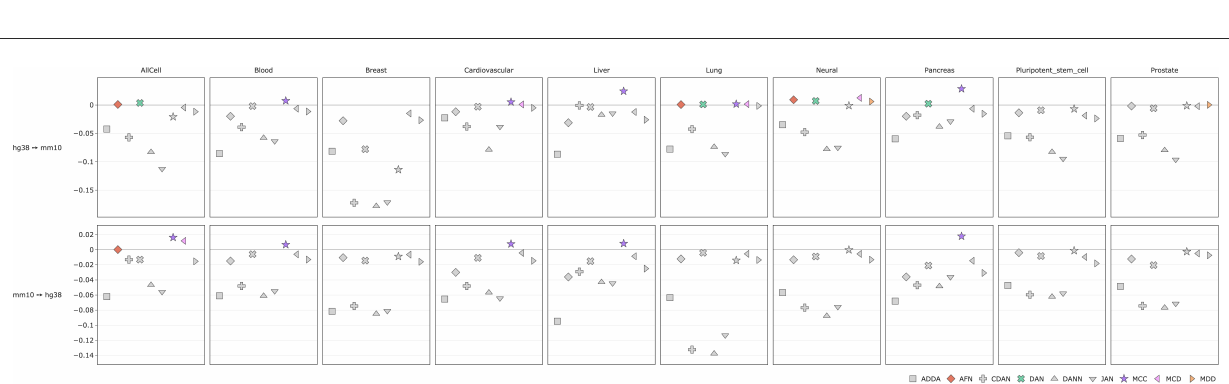
FIGURE6 Comparison of DA model performance (ROC AUC) across tissues for histone marks (see comparison based on PR AUC and accuracy in Supplementary Figure 4).